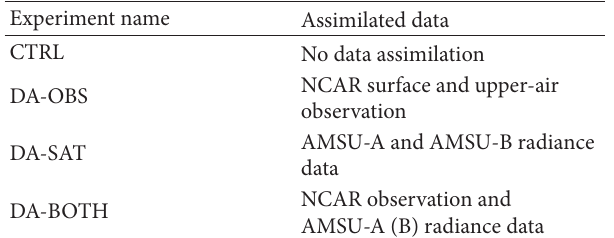
Table 1: Details of the observed data used in the assimilation